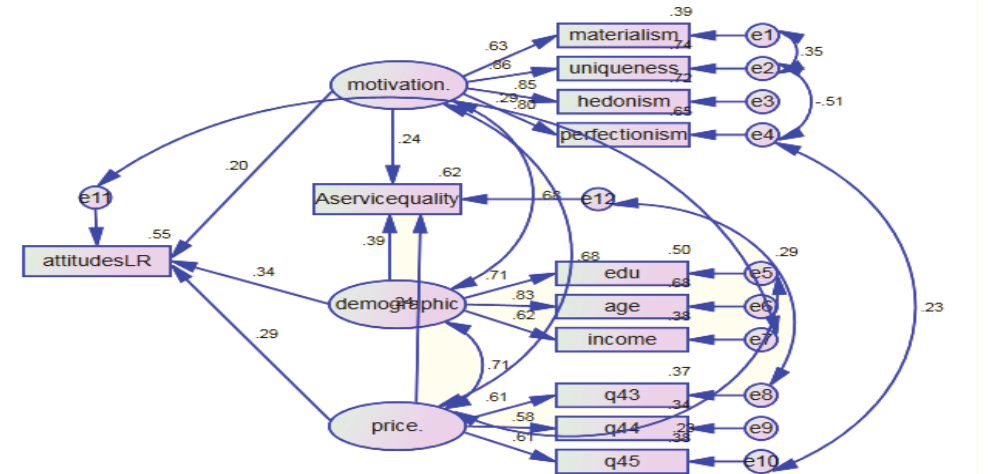
Fig. 2. Structural model of research (modified) with standard